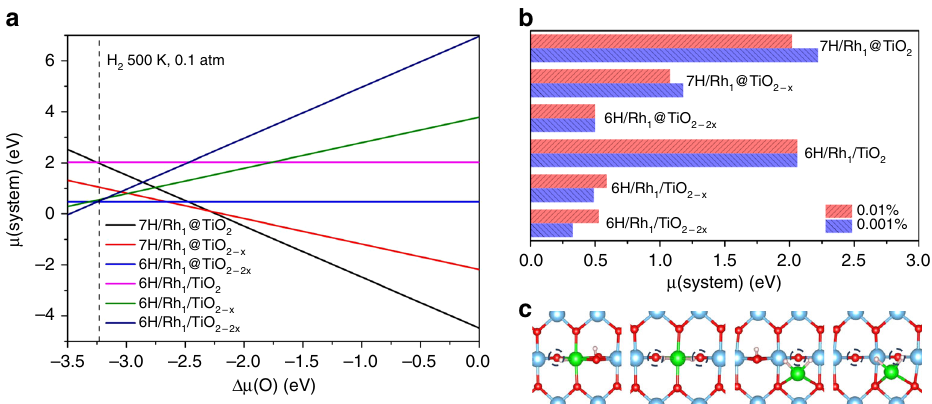
Fig. 2 Stability of single Rh atom on TiO 2 (110) under a pressure of H 2 . Substitutional (@) and supported (/) sites are compared. a Relative stability as a function of Δ μ (O) under a typical condition of H 2 reduction (H 2 pressure of 0.1 atm at 500 K, i.e. Δ μ (H) = − 0.35 eV). b Free energy for different Rh atom con fi gurations in speci fi c condition corresponding to water formation equilibrium ( Δ μ (H) = − 0.35 eV and Δ μ (O) = − 3.23 ( − 3.33) eV for 0.01% (0.001%) conversion). The dashed line in a represents the condition (0.01% conversion) in b . c The local environment of Rh SAs in Rh 1 @TiO 2 − x , Rh 1 @TiO 2 − 2 x , Rh 1 / TiO 2 − x , and Rh 1 /TiO 2 − 2 x (from left to right). Color code: O — red; Ti — blue; Rh — green. O vacancies are indicated by small dashed circles. Conversion fi xes the pressure of H 2 O. For instance, 0.01% conversion means a H 2 O pressure of 10 − 5 atm. Then μ (O) is obtained by μ (H 2 O) − μ (H 2